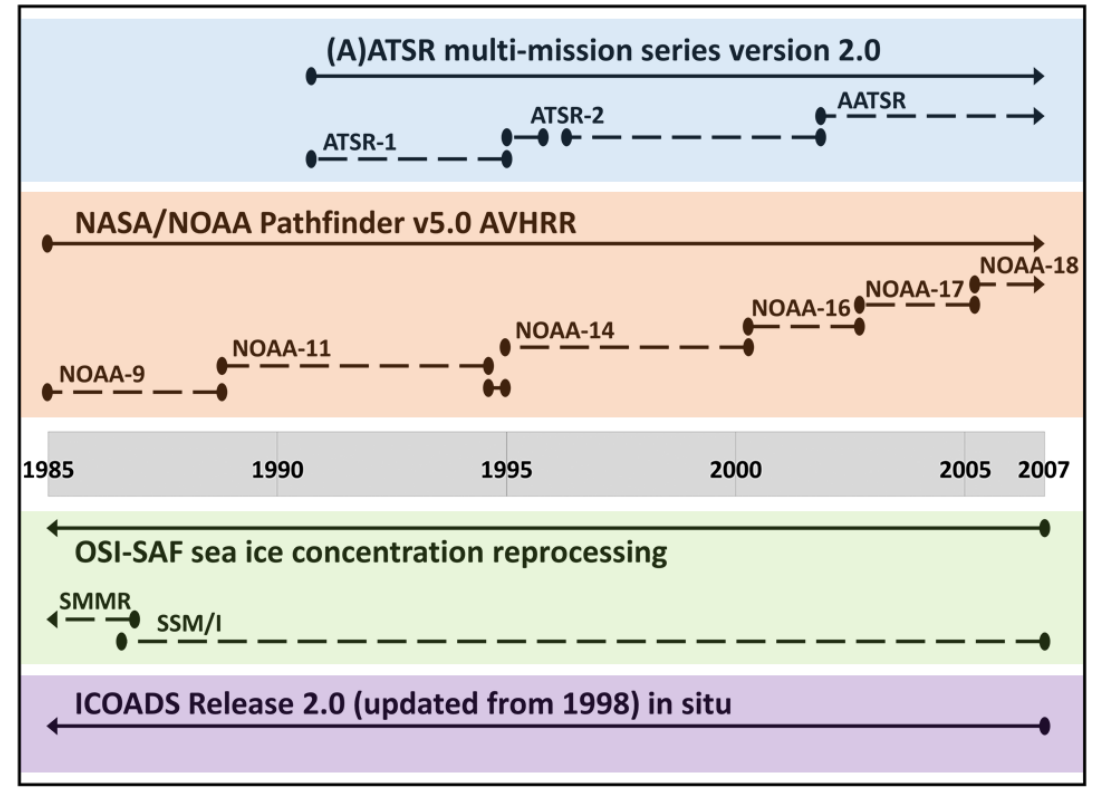
Figure 1. Timeline of availability of observational datasets for the Operational Sea Surface Temperature and Sea Ice Analysis (OSTIA) reanalysis (after Figure 1 in [8]). They include the (Advanced) Along-Track Scanning Radiometer ((A)ATSR) multi-mission series (blue shading), NASA/NOAA Pathfinder (orange shading), Ocean and Sea Ice Satellite Application Facility (OSI-SAF) sea ice concentration (green shading), and internal comprehensive Ocean Atmosphere Data Set (ICOADS) Release 2.0 in situ data (purple shading).